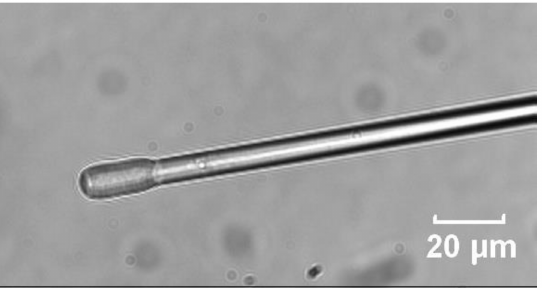
Figure 1. Microphotograph of the tip of a fiber-optic probe coated with the sensitive layer. The probe is connected to an optoelectronic unit through a standard FC-PC optical connector. The optoelectronic unit provides excitation of the sensitive layer and detection of the fluorescence emission using two laser diodes at wavelengths of 405 nm and 450 nm, a photomultiplier tube (PMT) and a pair of fiber-optic couplers/splitters. The laser diodes are switched on and off in alternate manner and corresponding intensities are measured synchronously by PMT. The unwanted back-scattered excitation radiation is eliminated utilizing a bandpass optical filter, which passes the light in a range from 475 nm to 525 nm (Figure 2).